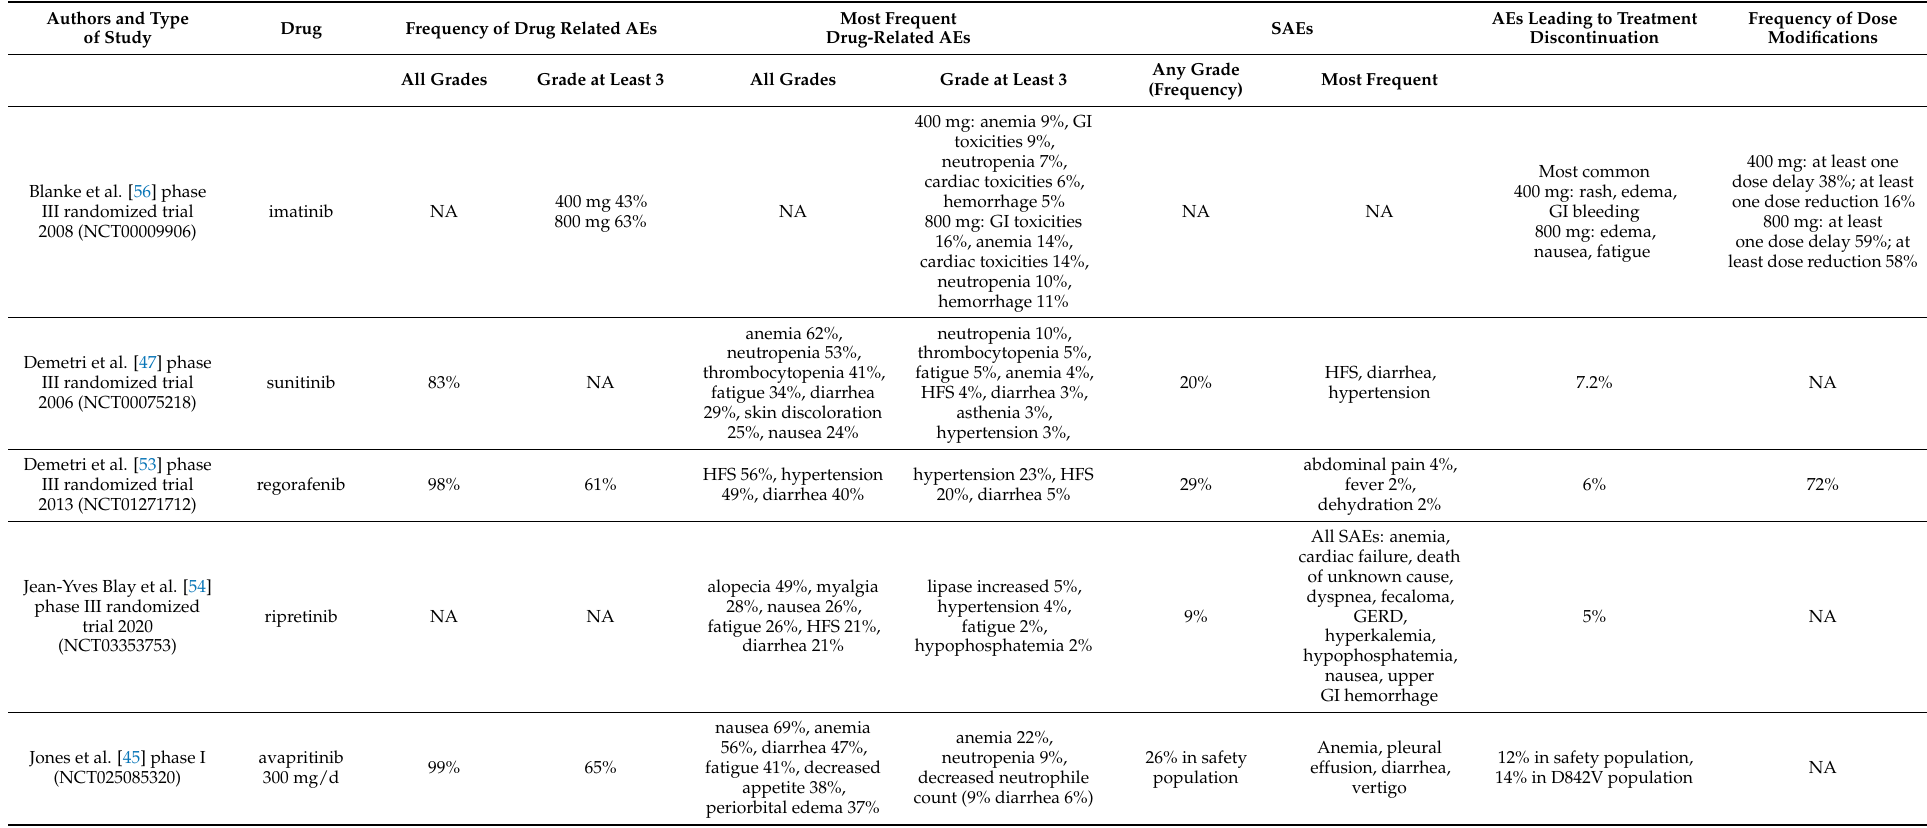
Table 3. Adverse events reported in clinical trials with drugs approved for the treatment of unresectable and metastatic